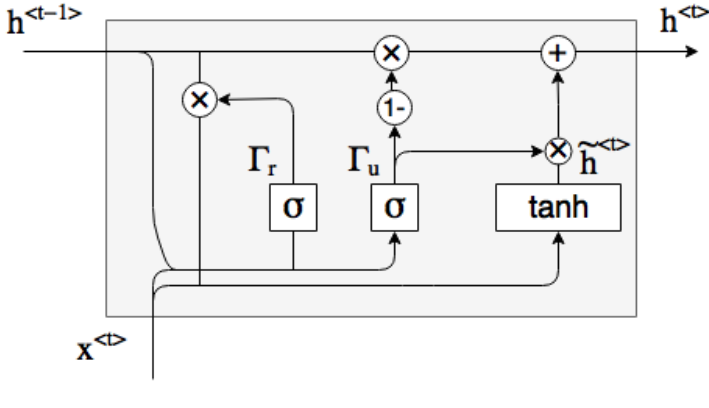
Figure 3. Gated recurrent